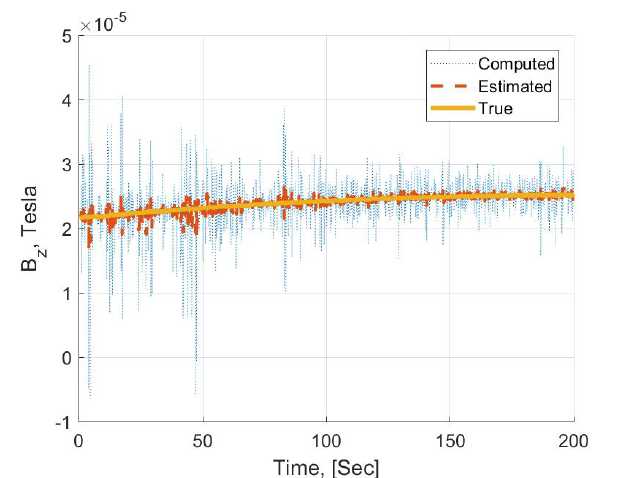
Figure 19. Magnetic field history in the Z direction for 1st maneuver.